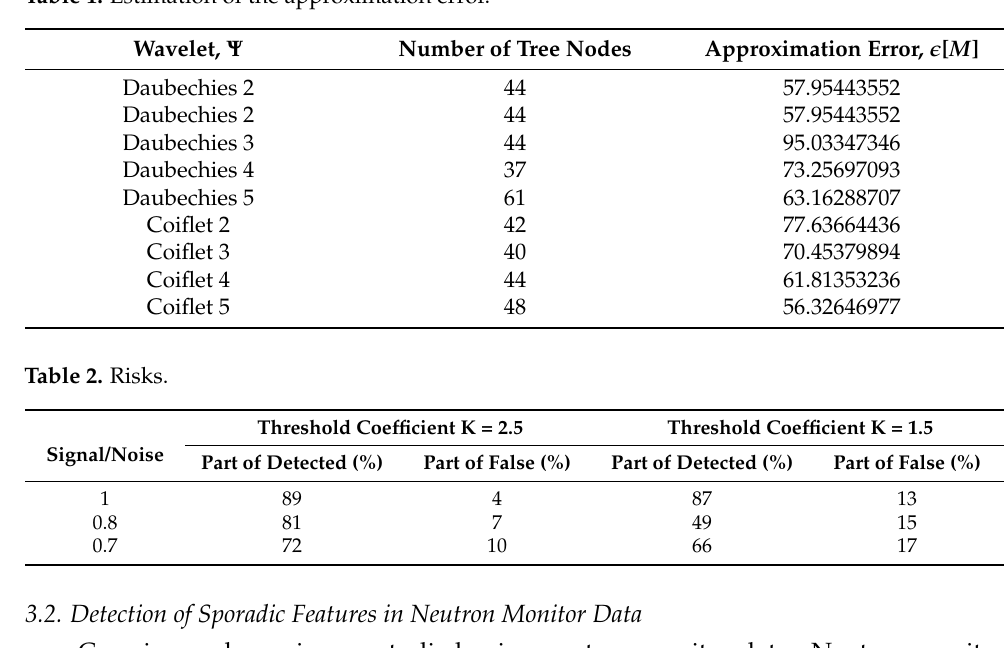
Figure 5. Results with different thresholds. Table 1. Estimation of the approximation error.